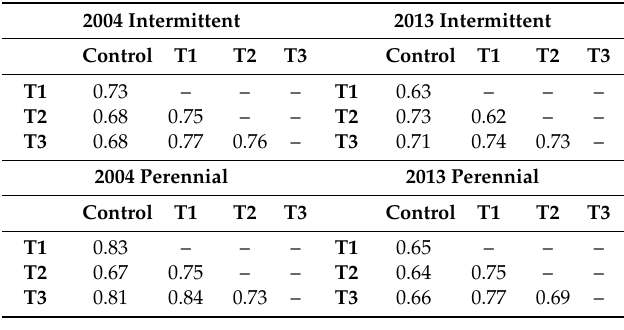
Table 4. Jaccard similarity index for benthic macroinvertebrate communities across SMZ treatments at Robinson Forest, Kentucky (USA).